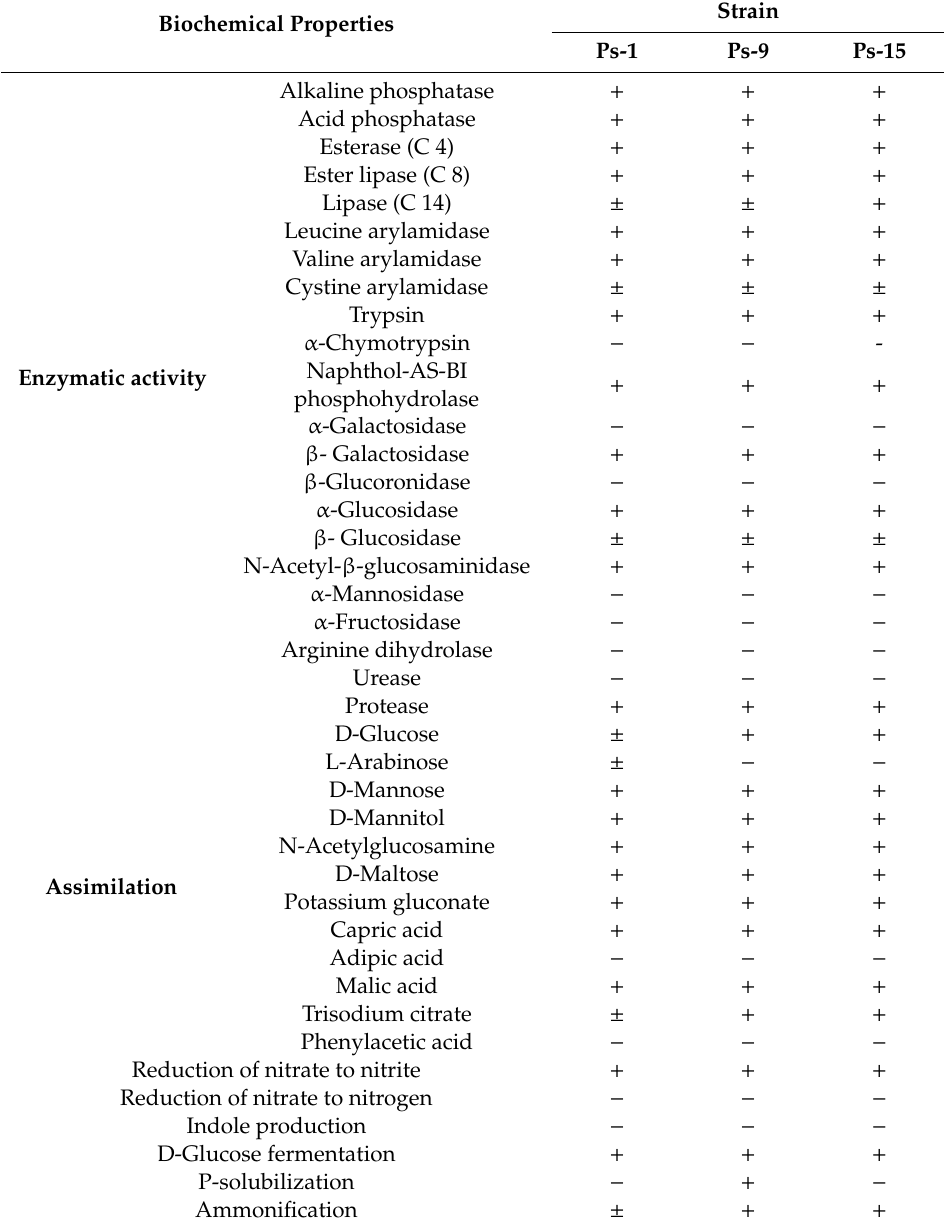
Table 2. Biochemical parameters of tested Ps-1, Ps-9, and Ps-15 bacteria